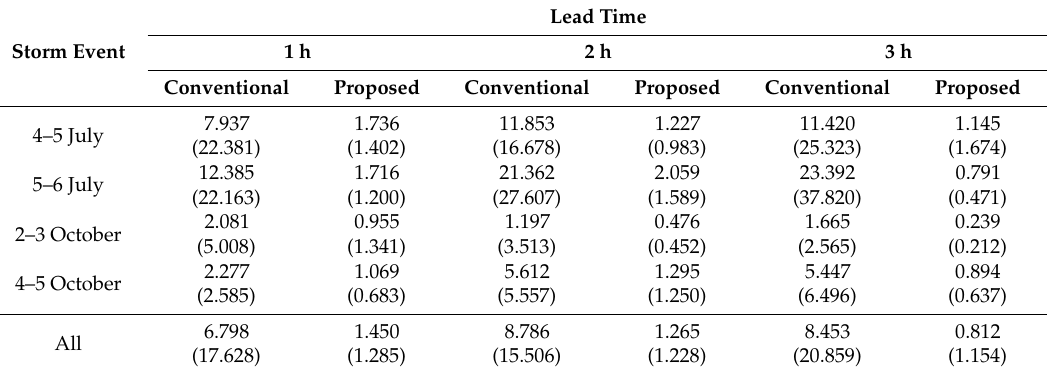
Table 3. Means and standard deviations (within the parenthesis) of bias correction ratio estimated for each storm event with respect to the lead